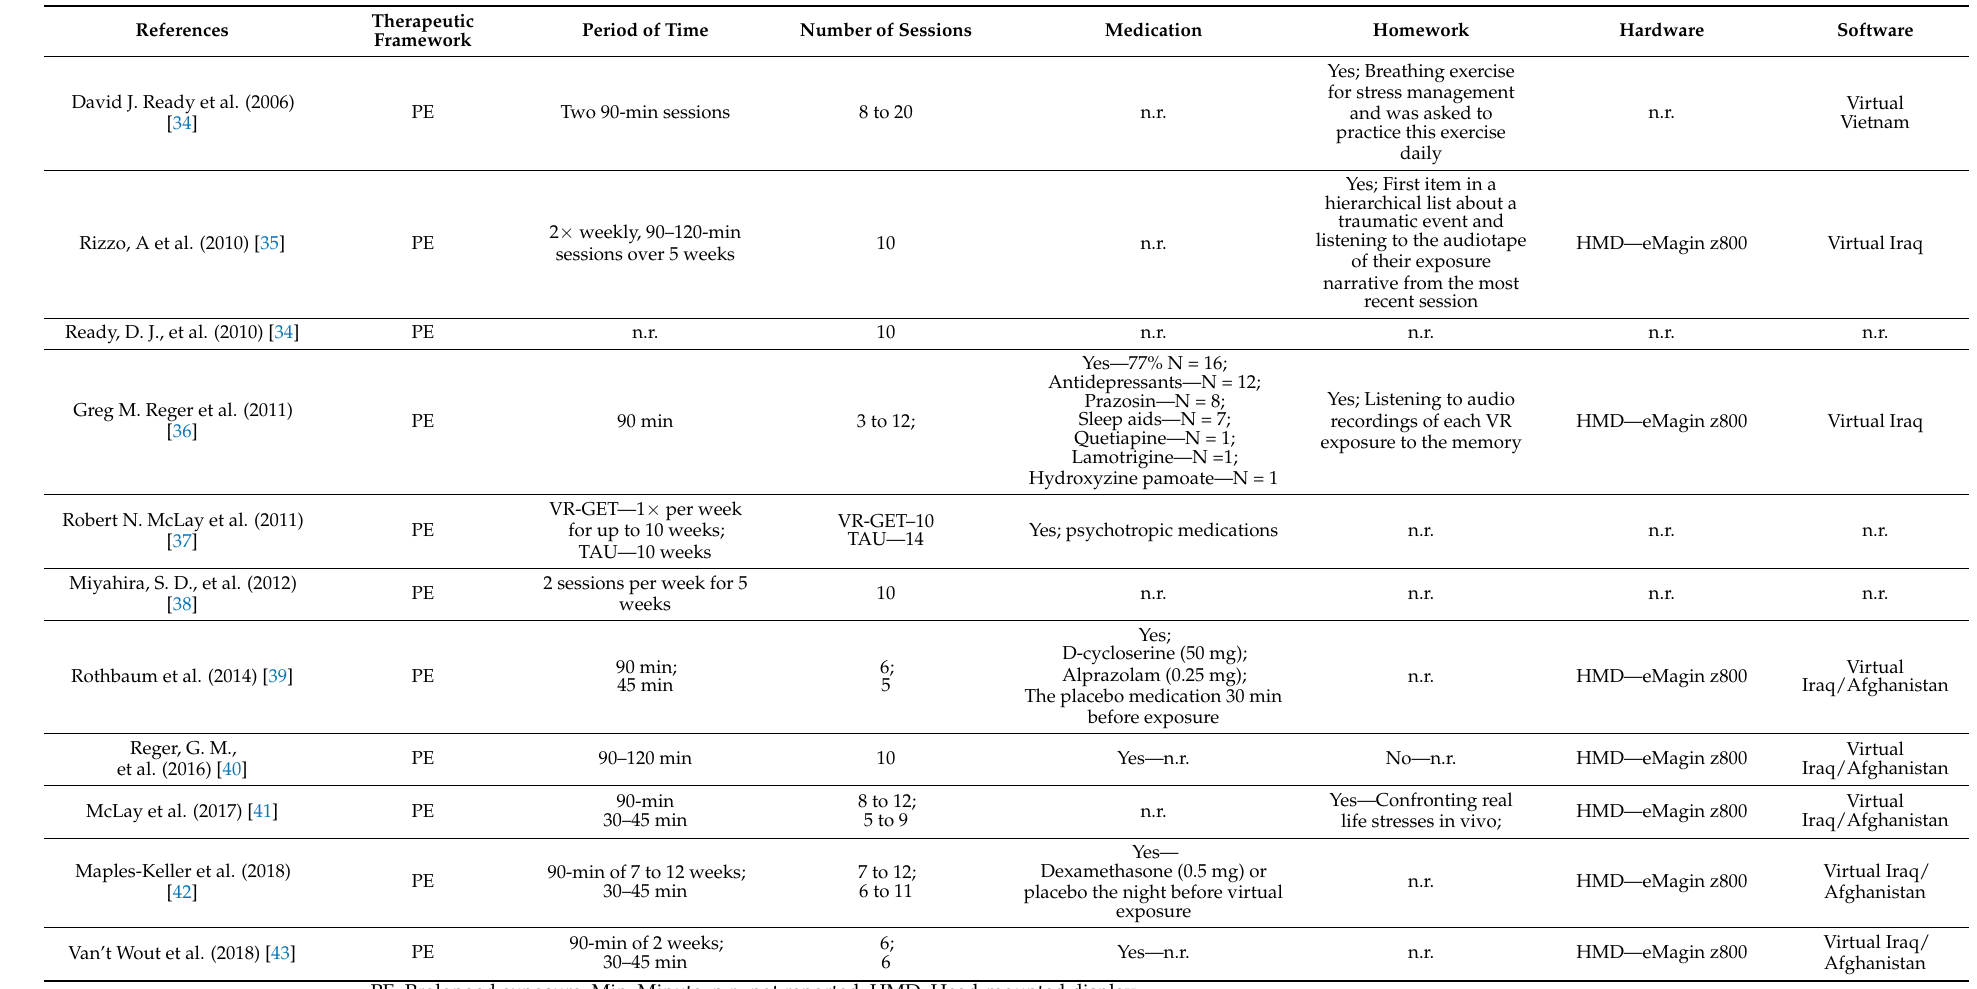
Table 2. Results of the qualitative analysis for each